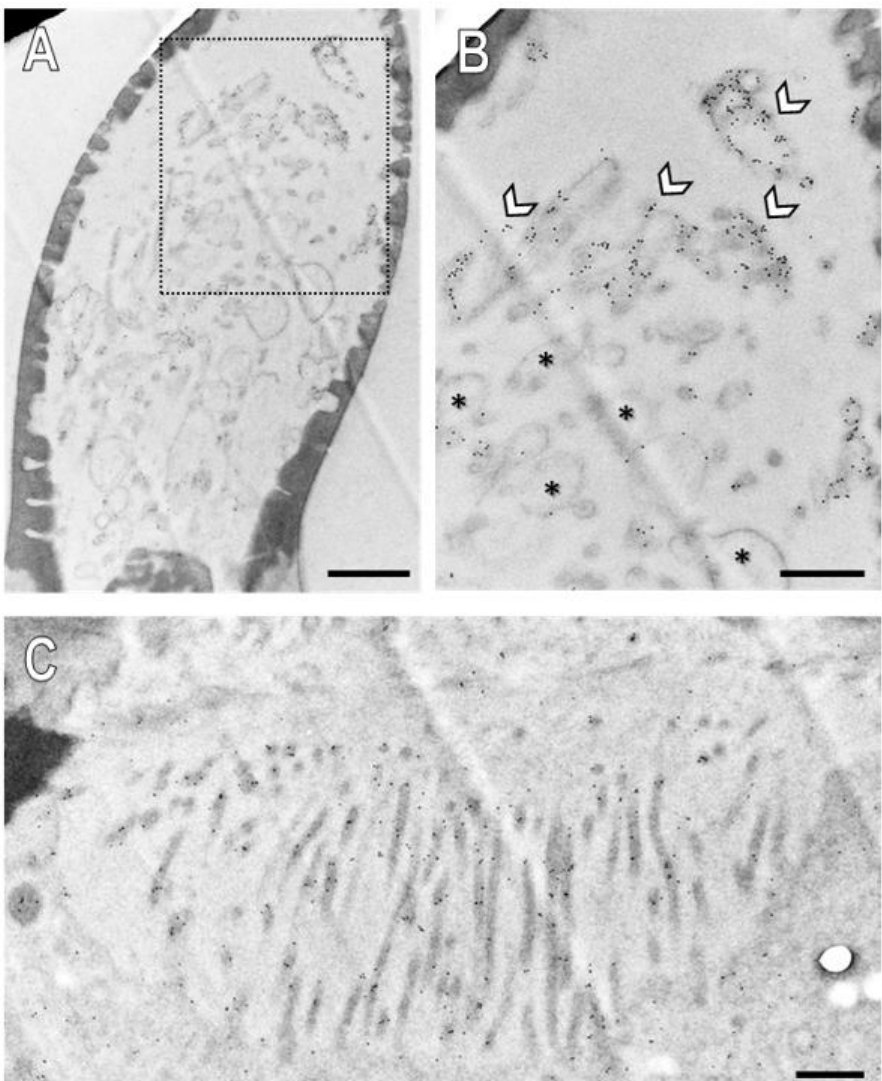
Figure 7. Subcellular localization of SNMP1 within a basiconic sensillum of the S. gregaria. Ultrathin sections were assessed by transmission electron microscopy after treatment with anti-SNMP1-ab and a secondary anti-rabbit antibody coupled with colloidal gold. ( A ) Shaft of a basiconic sensillum with multiple dendritic structures in the lumen. ( B ) Higher magnified image of the area boxed in ( A ). Intense immunogold labelling is observed associated with the membranes of a subset of dendritic structures (arrows). The asterisks denote dendritic structures with little to no immunogold labelling. ( C ) Microvilli structures of support cells at the base of the sensillum. Significant immunogold labelling was found associated with the microvilli including their membranes. Scale bars: ( A ) = 1 µm; ( B , C ) = 500 nm.